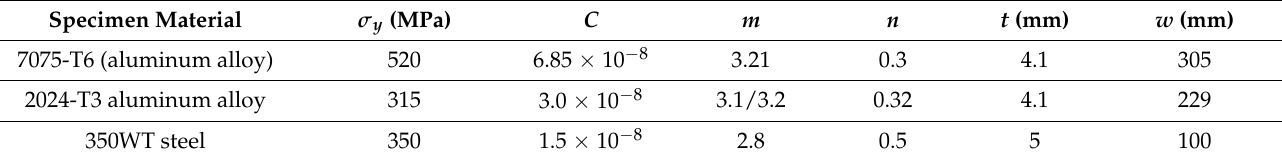
Table 5. Geometry and material variation in